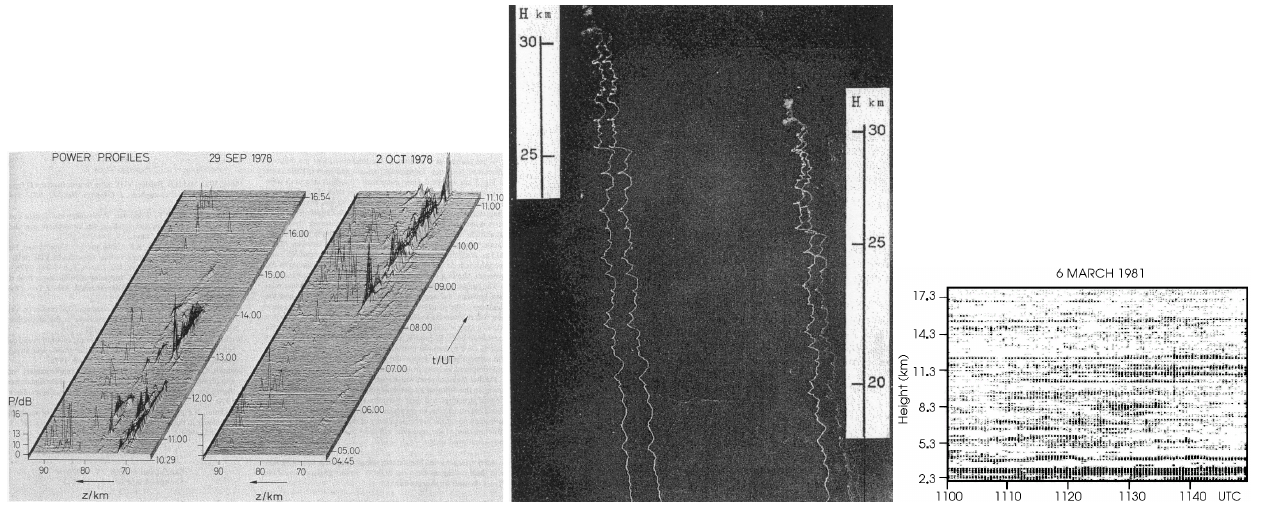
Fig. 1. (a) Illustration of stratification of radar echoes at VHF (from Czechowsky et al., 1979). (b) Evidence of horizontal stratification of atmospheric winds using in situ techniques (smoke trails). (c) Stratification of persistent thin sheets in the troposphere and lower stratosphere (from Hocking and R¨ottger,